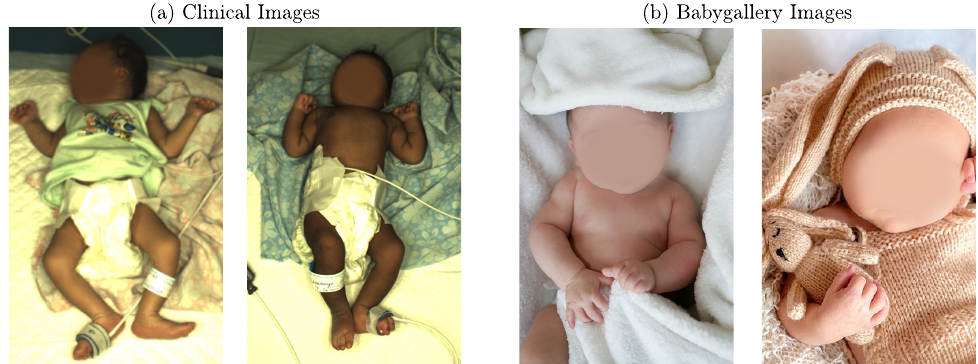
Figure 2. Example images for ( a ) clinical dataset and ( b ) baby gallery dataset (faces intentionally